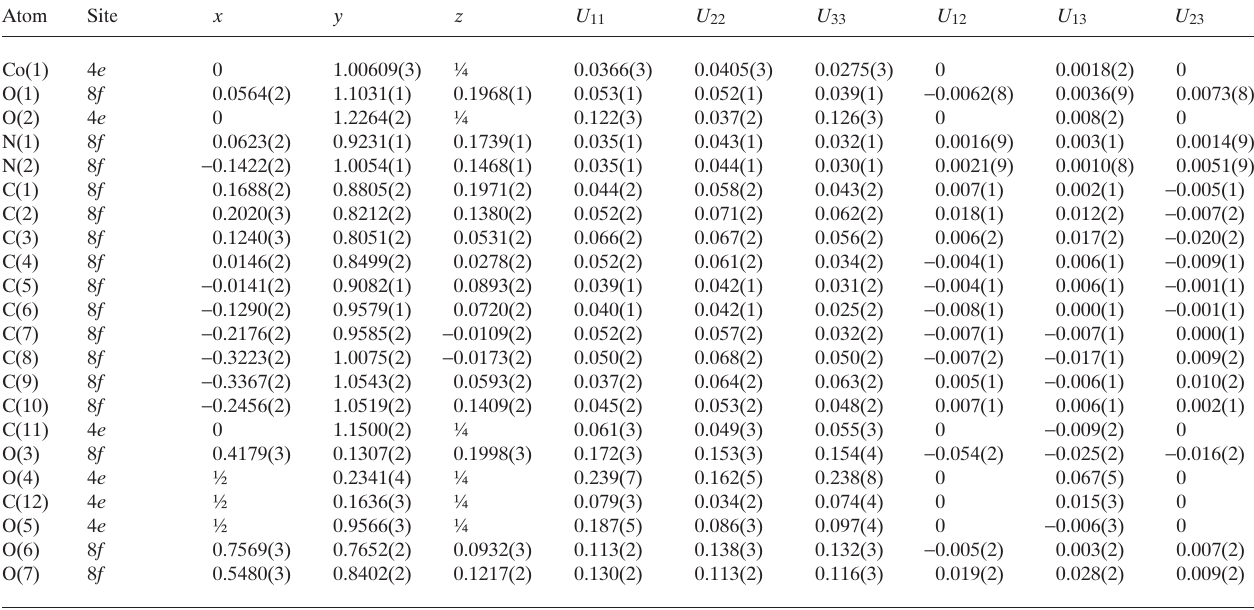
Table 3. Atomic coordinates and displacement parameters (in Å 2 ) .